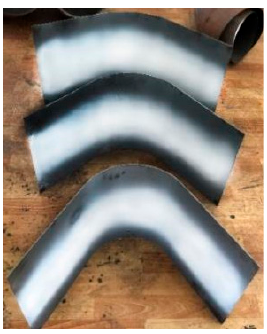
Figure 10. Coatings on arc connecting surfaces obtained from the experiment.